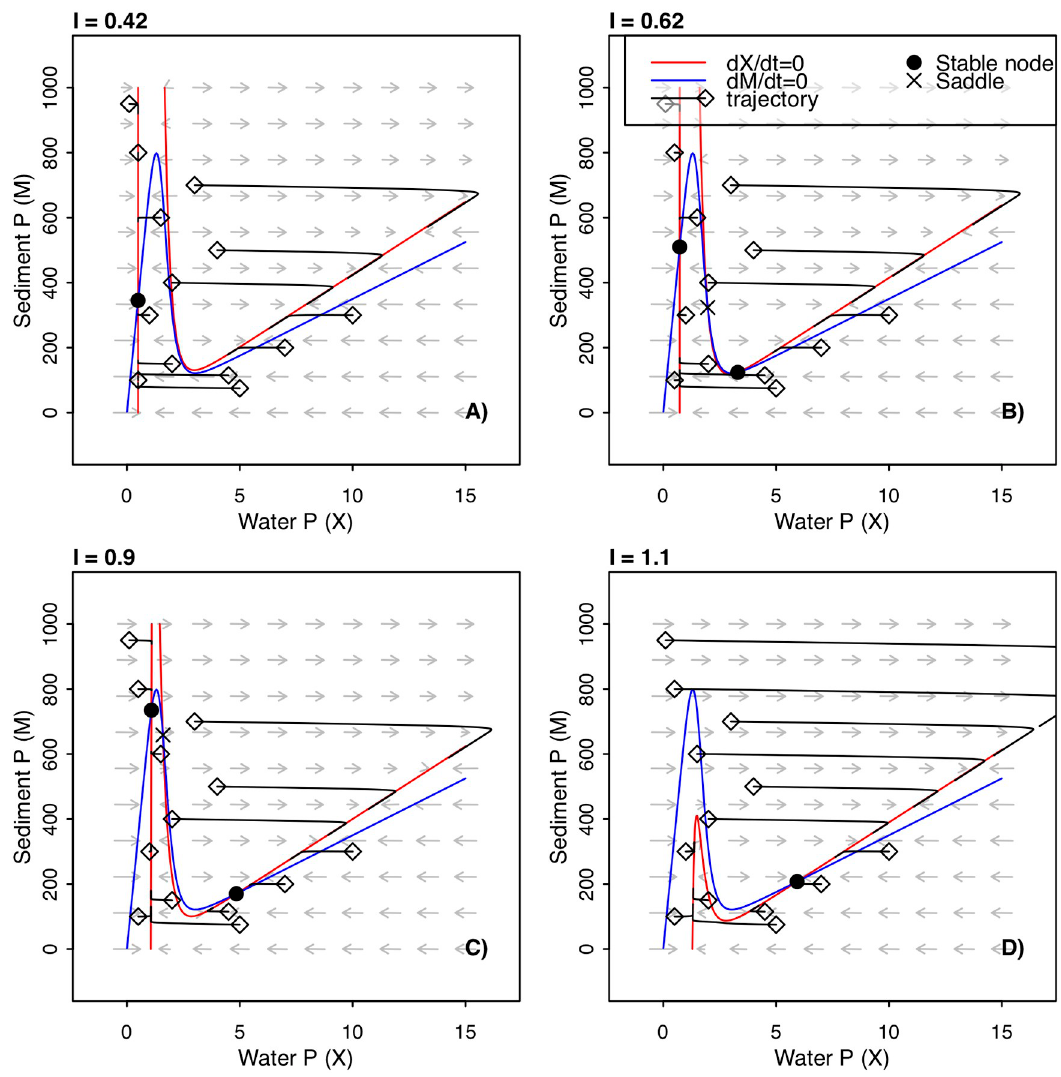
Fig 1. A phase portrait of the model system for varying values of P input. The vector field is represented by gray arrows. Nullclines are represented by red and blue lines, indicating where dX/dt and dM/dt are equal to zero, respectively. Trajectories starting at arbitrary initial points (open diamonds) and continuing along the accompanying solid black line indicate how the system moves from the initial point through phase space for 50 years. Equilibria are indicated by points: solid filled circle is a stable node, an ‘X’ is a saddle point. An equilibrium occurs where the nullclines cross. The different panels correspond to different values of P loading ( I ).